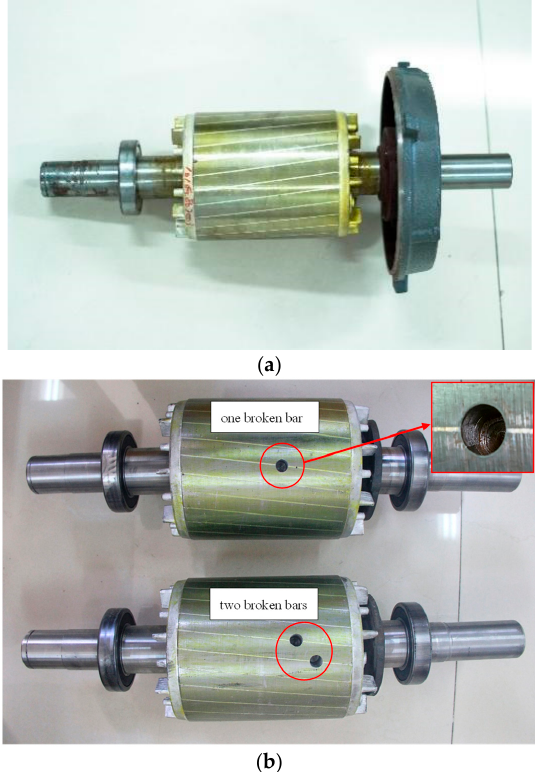
Figure 14. Experimental rotors:( a ) healthy rotor; ( b ) rotor with broken bars.